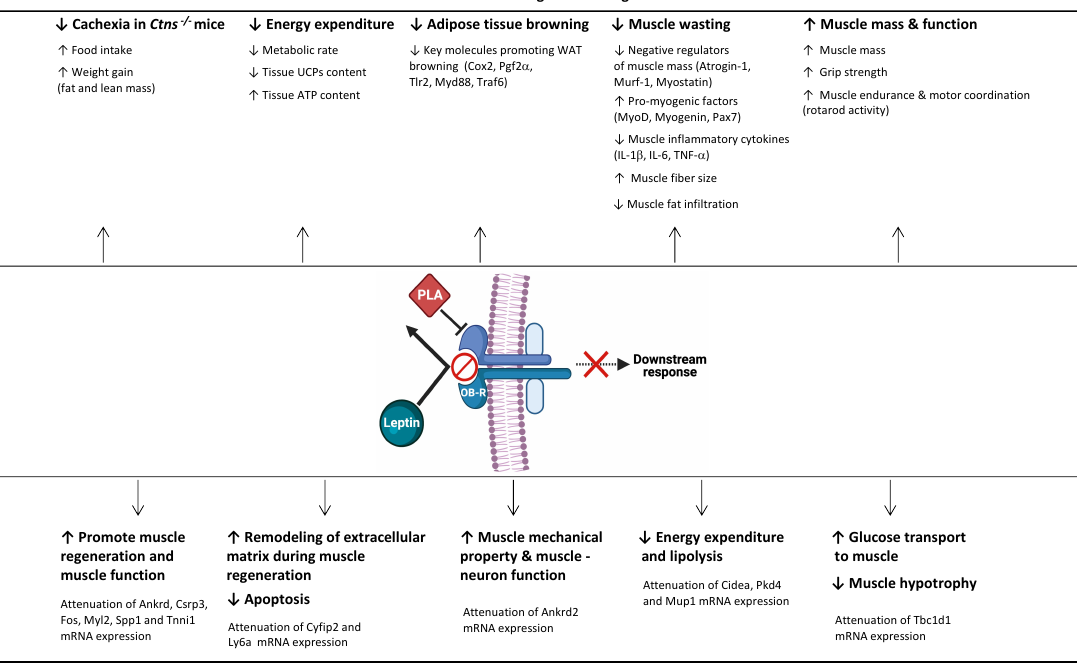
Figure 7. Summary of the beneficial effects of a leptin receptor antagonist on cachexia, energy expenditure, adipose tissue browning and muscle wasting in Ctns −/− mice. Created with BioRender.com, accessed 18 May 2021. Supplementary Materials: The following are available online at www.mdpi.com/xxx/s1, Table S1: Immunoassay information for blood and serum chemistry, muscle adenosine triphosphate content